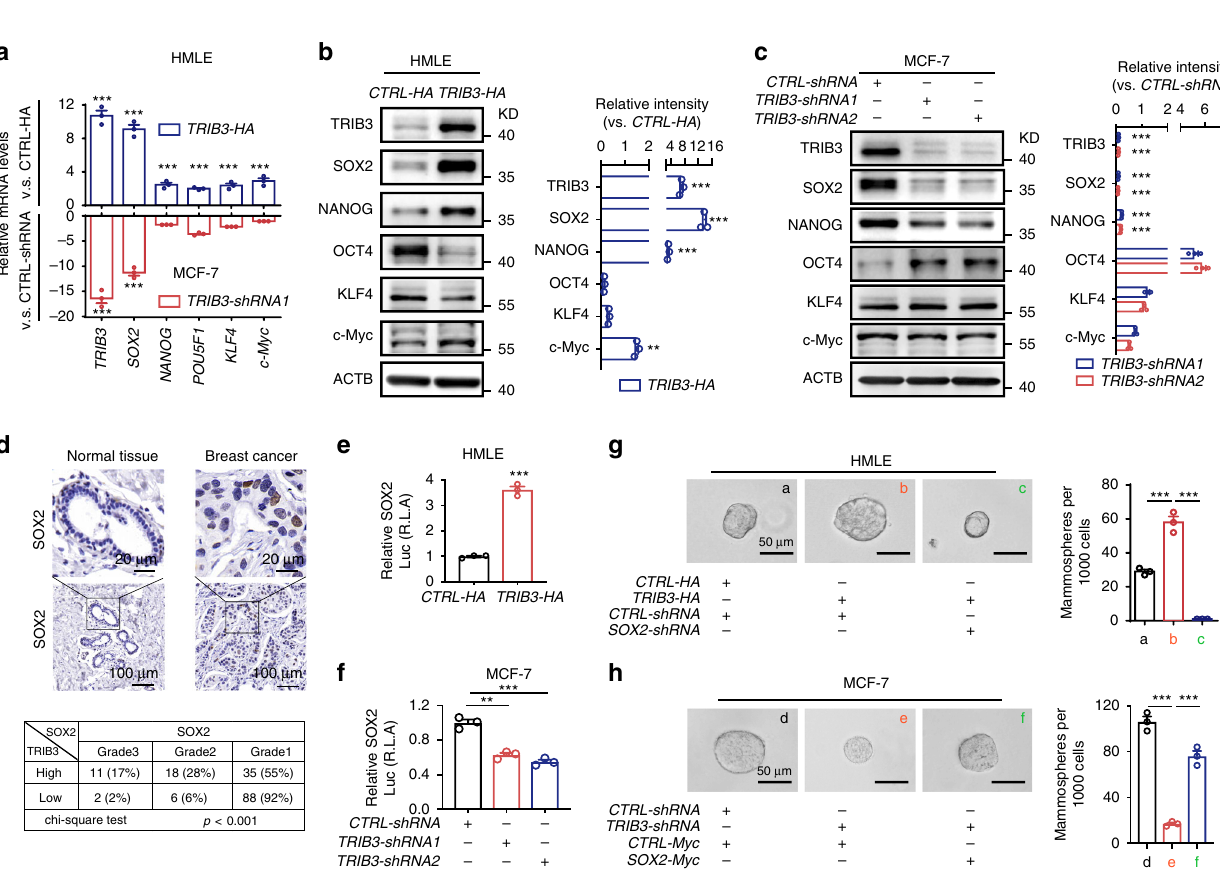
Fig. 3 TRIB3 enhances SOX2 expression in BCCs. a Histogram showing the expression of TRIB3 (far left) and stem cell-related genes in HMLE cells transfected with TRIB3 -expressing vector vs. control vector and MCF7 cells transfected with TRIB3-shRNA1 vs. CTRL-shRNA . b , c Immunoblots and statistical analysis ( n = 3) of protein lysates, as indicated on the left, transfected with a control vector or a TRIB3 -expressing vector for HMLE cells ( b ) or with CTRL-shRNA , or TRIB3-shRNA for MCF7 cells ( c ). d Formalin- fi xed, paraf fi n-embedded tissue microarray sections of normal and breast cancer tissues were stained with an anti-SOX2 antibody. Tissue-bound SOX2 is shown in brown (top). A 3 × 2 contingency table shows the correlation between TRIB3 and SOX2 based on their relative expression, graded by the percentage and intensity of the brown color staining in the immunohistological images (bottom). e Overexpression of TRIB3 enhanced the SOX2 transcriptional activity in HMLE cells, as determined by a luciferase reporter assay. f Silencing TRIB3 inhibited the SOX2 transcription activity in MCF7 cells, as determined by a luciferase reporter assay. g , h Tumor spheroid formation ability of HMLE cells ( g ) transfected with a control vector or a TRIB3-expressing vector and either CTRL-shRNA or SOX2-shRNA (as indicated at the bottom) or of MCF7 cells ( h ) transfected with CTRL-shRNA or TRIB3-shRNA , and either a control vector or a SOX2-expressing vector. All data are shown as the number of mammospheres per 1000 cells. Data are presented as the mean ± SEM of three independent assays; P > 0.05 was considered not signi fi cant (NS); * P < 0.05, ** P < 0.01, and *** P < 0.001 compared with the vector or CTRL-shRNA group. Source data are provided as a Source Data fi factors reduced tumorsphere formation in HMLE cells (Supple- HMLE cells transfected with a TRIB3-expressing vector to form mentary Fig. 3c top). In HMLE-TRIB3 cells, silencing anyone of spheroids (Fig. 3g). Overexpression of SOX2 rescued the spheroid SOX2 , NANOG , c-Myc could reduce tumorspheres; however, formation capacity of TRIB3-silenced MCF7 (Fig. 3h) and MDA- silencing only SOX2 completely blocked TRIB3-promoted 231 cells (Supplementary Fig. 3e). Silencing SOX2 had no tumorsphere formation (Supplementary Fig. 3c top). Silencing additional effects in terms of reducing of CD44 Br CD24 Di subpopulation and limiting tumorsphere formation in TRIB3- TRIB3 have additional effect in NANOG-shRNA , OCT4-shRNA , shRNA MCF7 cells (Supplementary Fig. 3f, g). These data suggest KLF4-shRNA , c-Myc-shRNA MCF7 cells, but not in SOX2-shRNA that elevated SOX2 expression is responsible for TRIB3- MCF7 cells (Supplementary Fig. 3c bottom). These results indi- supported breast cancer stemness. cated that SOX2 is a major factor that mediates TRIB3-supporting breast cancer stemness. We thus focused on the effect of the TRIB3-SOX2 axis on breast cancer stemness.